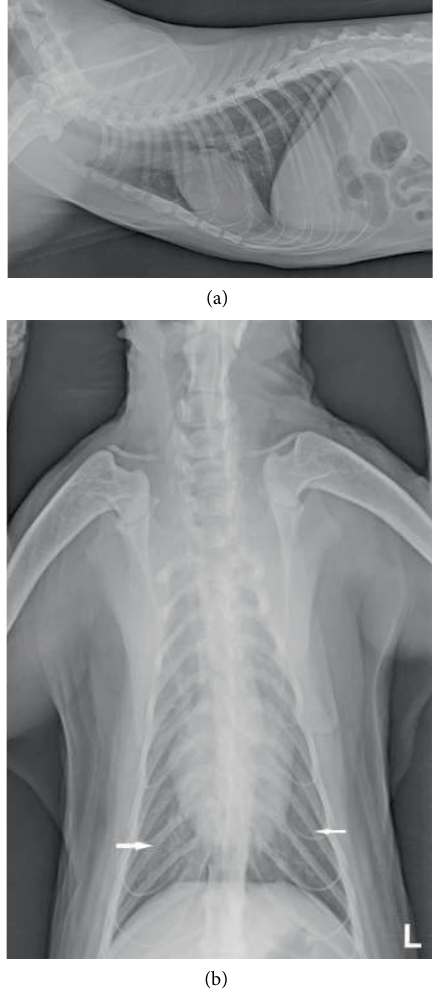
Figure 3: (a) Right lateral view. Lung lobes showed resolution of abnormal lung patterns. (b) Dorsoventral view. Presence of mild interstitial pattern in the caudal lung lobes (white